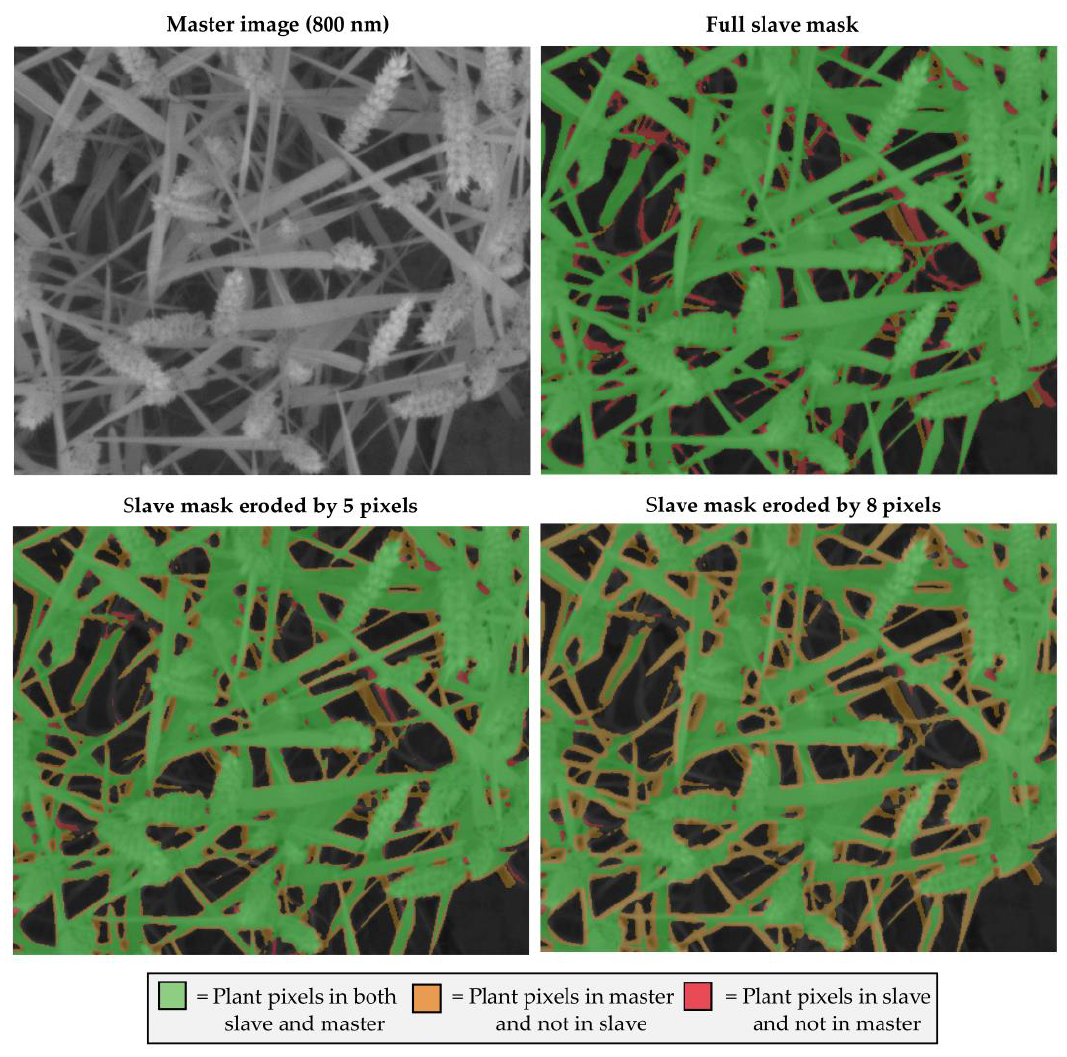
Figure 12. Example of plant mask erosion. Plant mask of the aligned slave image is considered as the reference for image fusion. In that case, eroding the mask avoid selecting pixels from the master image that do not represent plants (the red pixels on this example).